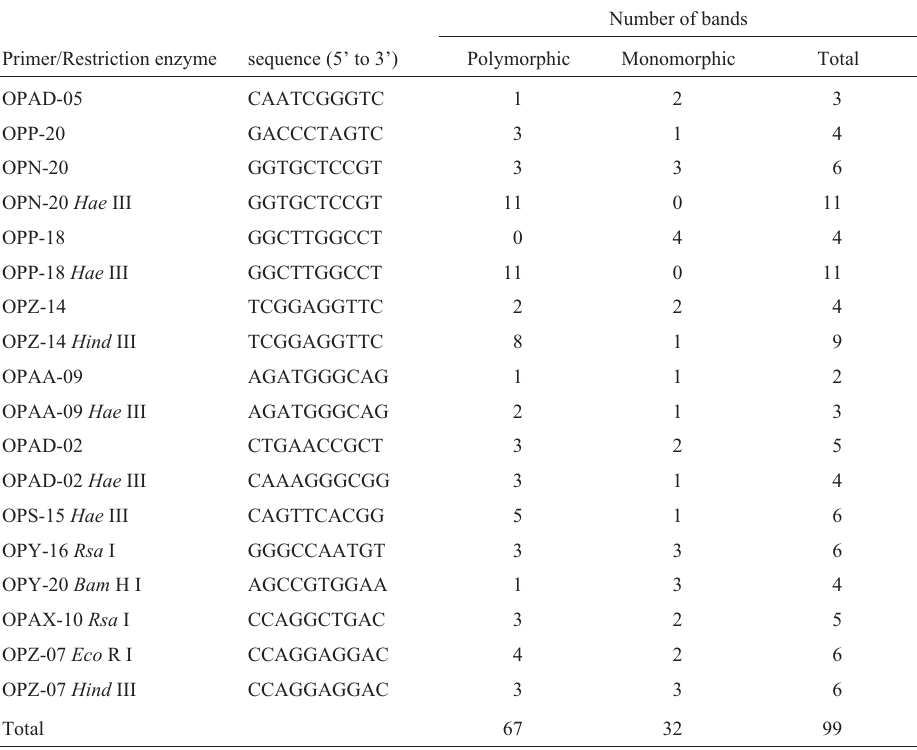
Table 1 - Primer sequences and primer/enzyme combinations used in the RAPD reaction of coffee accessions showing numbers of polymorphic and monomorphic